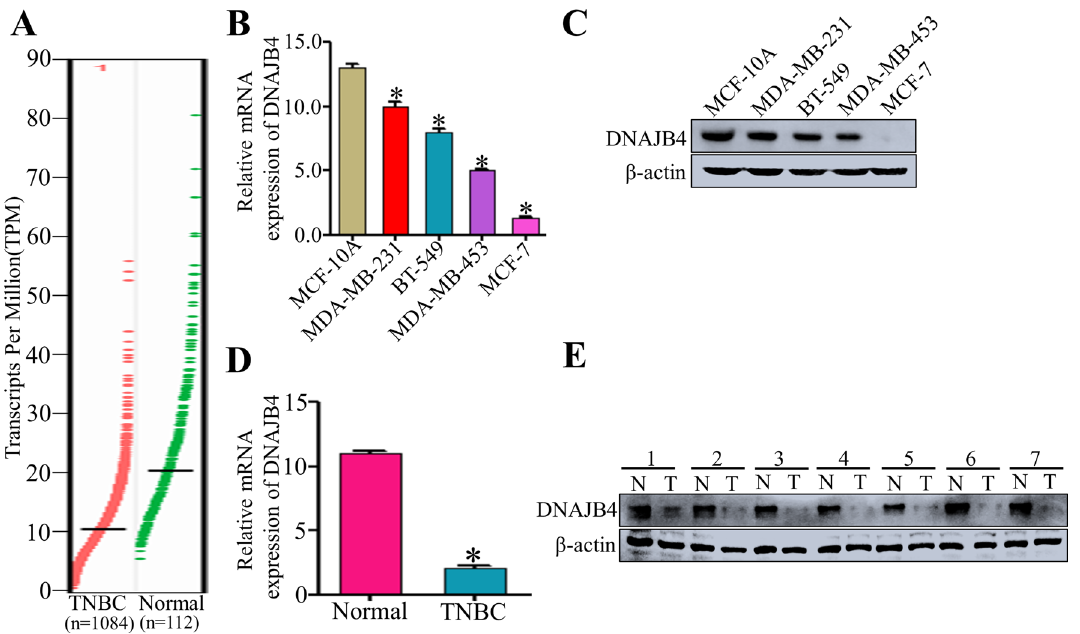
Fig. 1 DNAJB4 expression is highly downregulated in breast cancer cells and tissues. A Relative DNAJB4 mRNA expression in normal breast tissues (n = 112) and breast cancer tissues (n = 1084) acquired from the GEPIA database. Bar graph data are presented as the mean ± SEM; *, P < 0.05. B Relative DNAJB4 mRNA expression in normal breast cell (MCF-10A) and breast cancer cell lines (MDA-MB-231, BT-549, MDA- MB-453, and MCF-7) determined by qRT-PCR. Bar graph data are presented as the mean ± SEM; *, P < 0.05. C Western blot analysis of DNAJB4 expression in normal breast cell (MCF-10A) and breast cancer cell lines (MDA-MB-231, BT-549, MDA-MB-453, and MCF-7). β-actin was used as a loading control. D Relative DNAJB4 mRNA expression in matched primaryTNBC tissues and adjacent noncancerous tissues determined by qRT-PCR. Bar graph data are presented as the mean ± SEM; *, P < 0.05. E Western blot analysis of DNAJB4 expression in seven pairs of matched primary TNBC tissues (T) and adjacent noncancerous tissues (ANT). β-actin was used as a loading